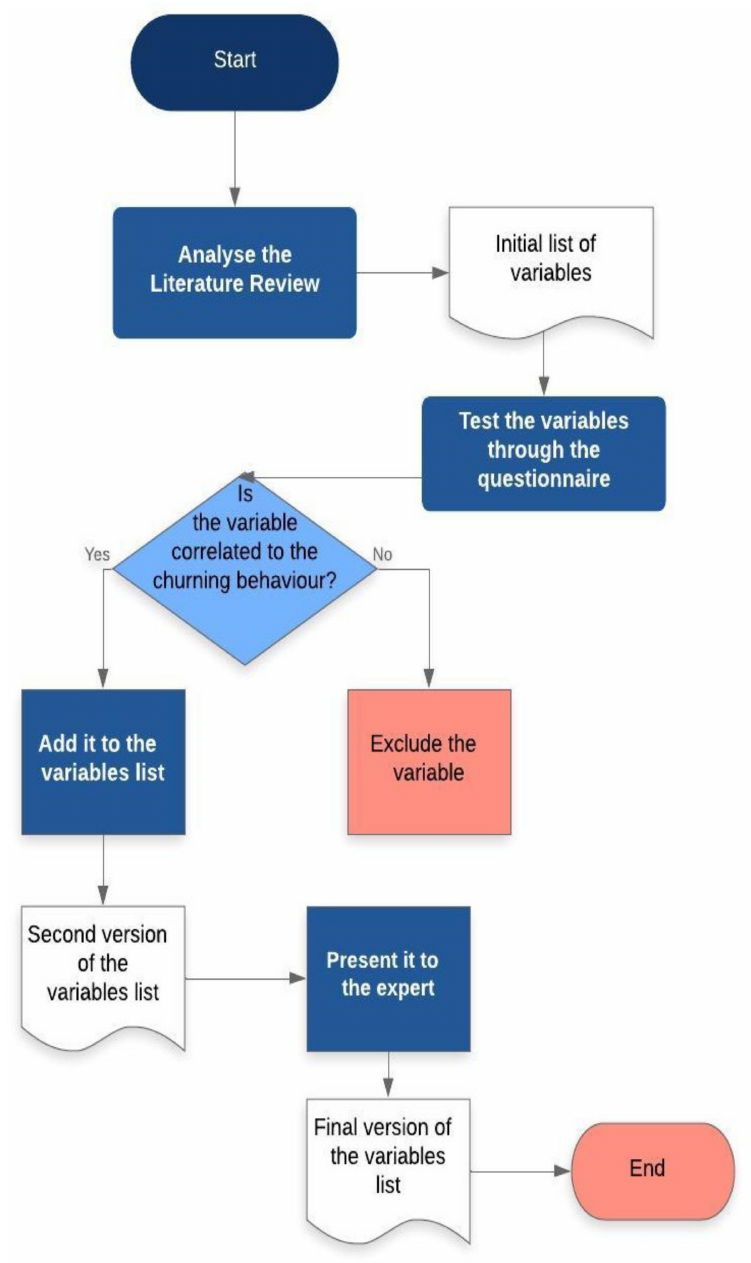
Figure 3. Workflow to develop the customer churn